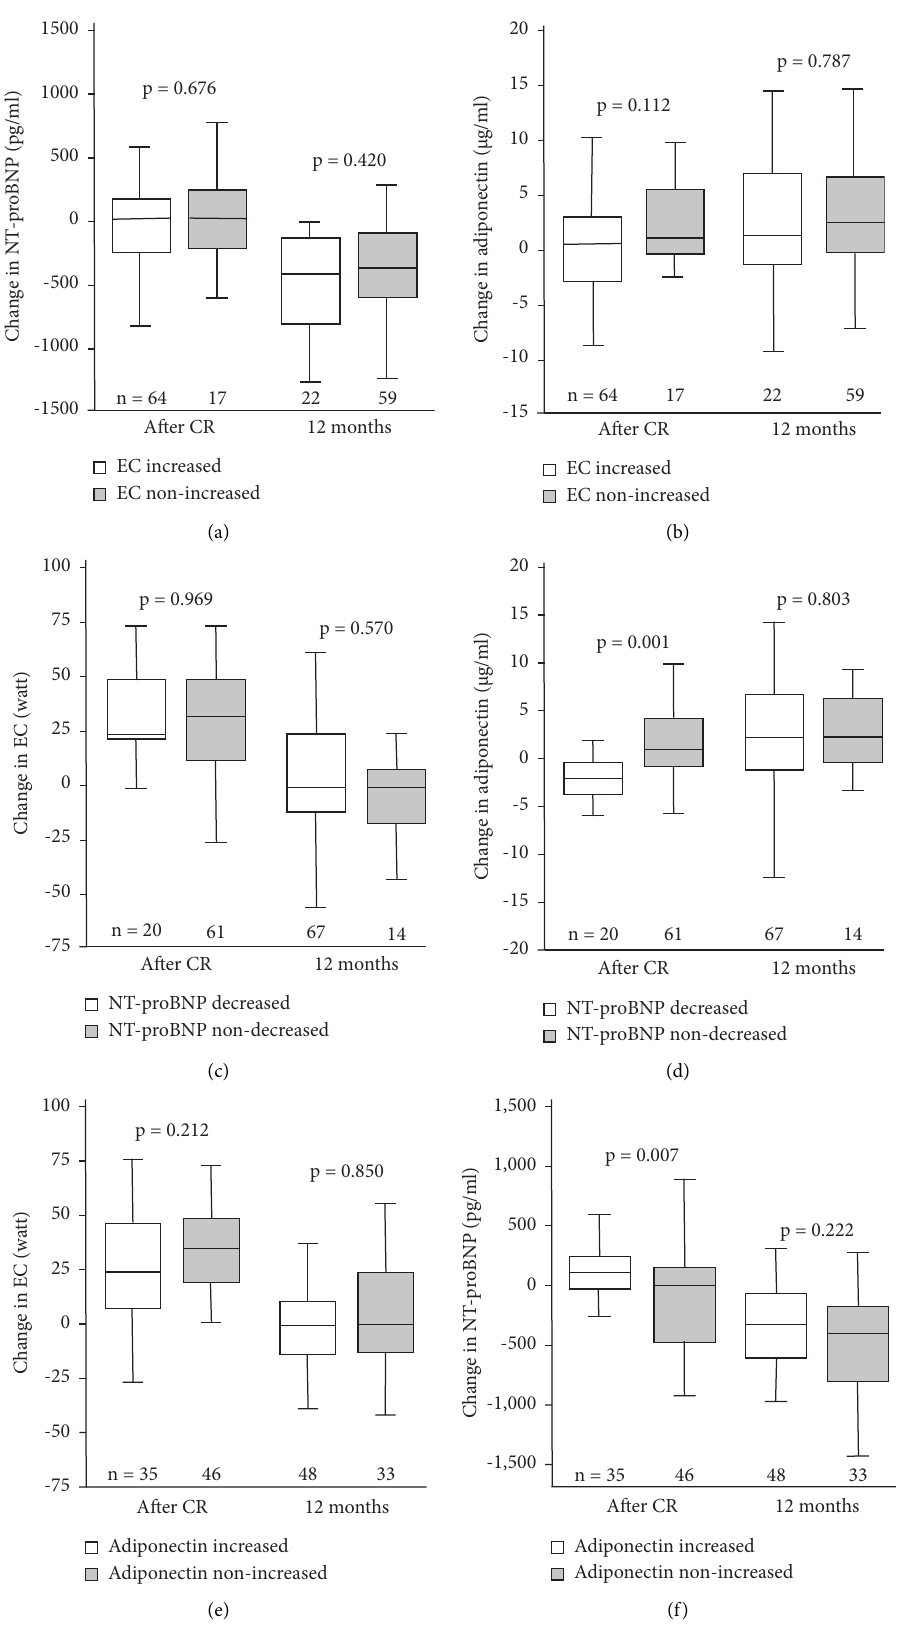
Figure 5: Structured analyses on changes in N-terminal part of the pro-brain natriuretic peptide (NT-proBNP), adiponectin, and exercise capacity (EC) during cardiac rehabilitation (CR) and at 12-month